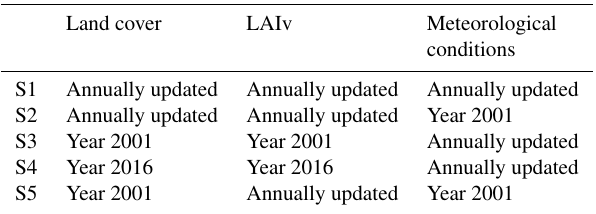
Table 1. Description of different scenarios used to estimate